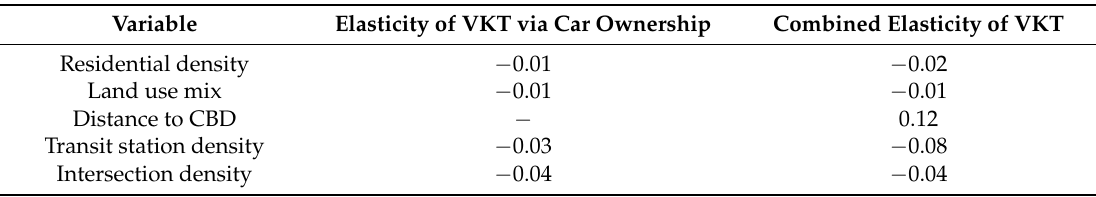
Table 5. Elasticities of household VKT with built environment